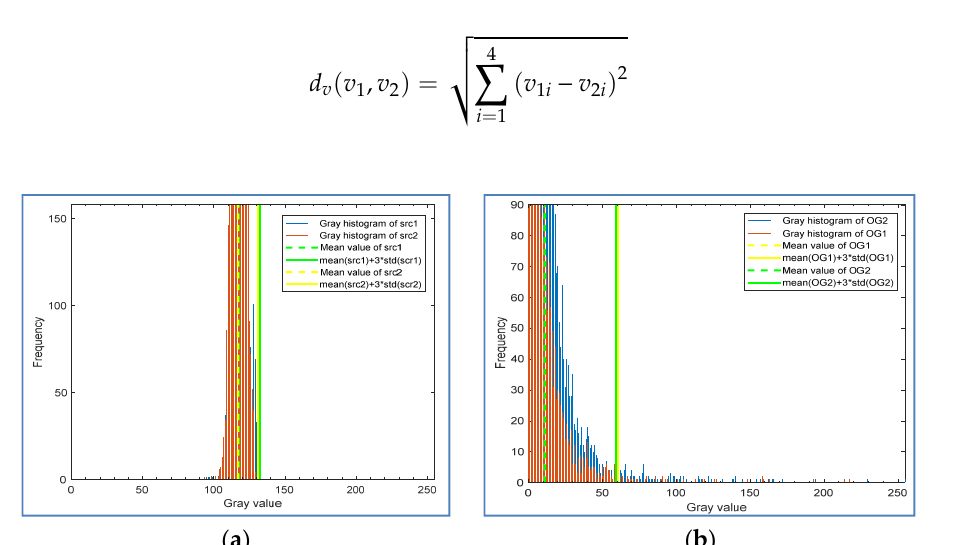
Figure 10. Histogram and statistical information of two similar regions: ( a ) original images; ( b )